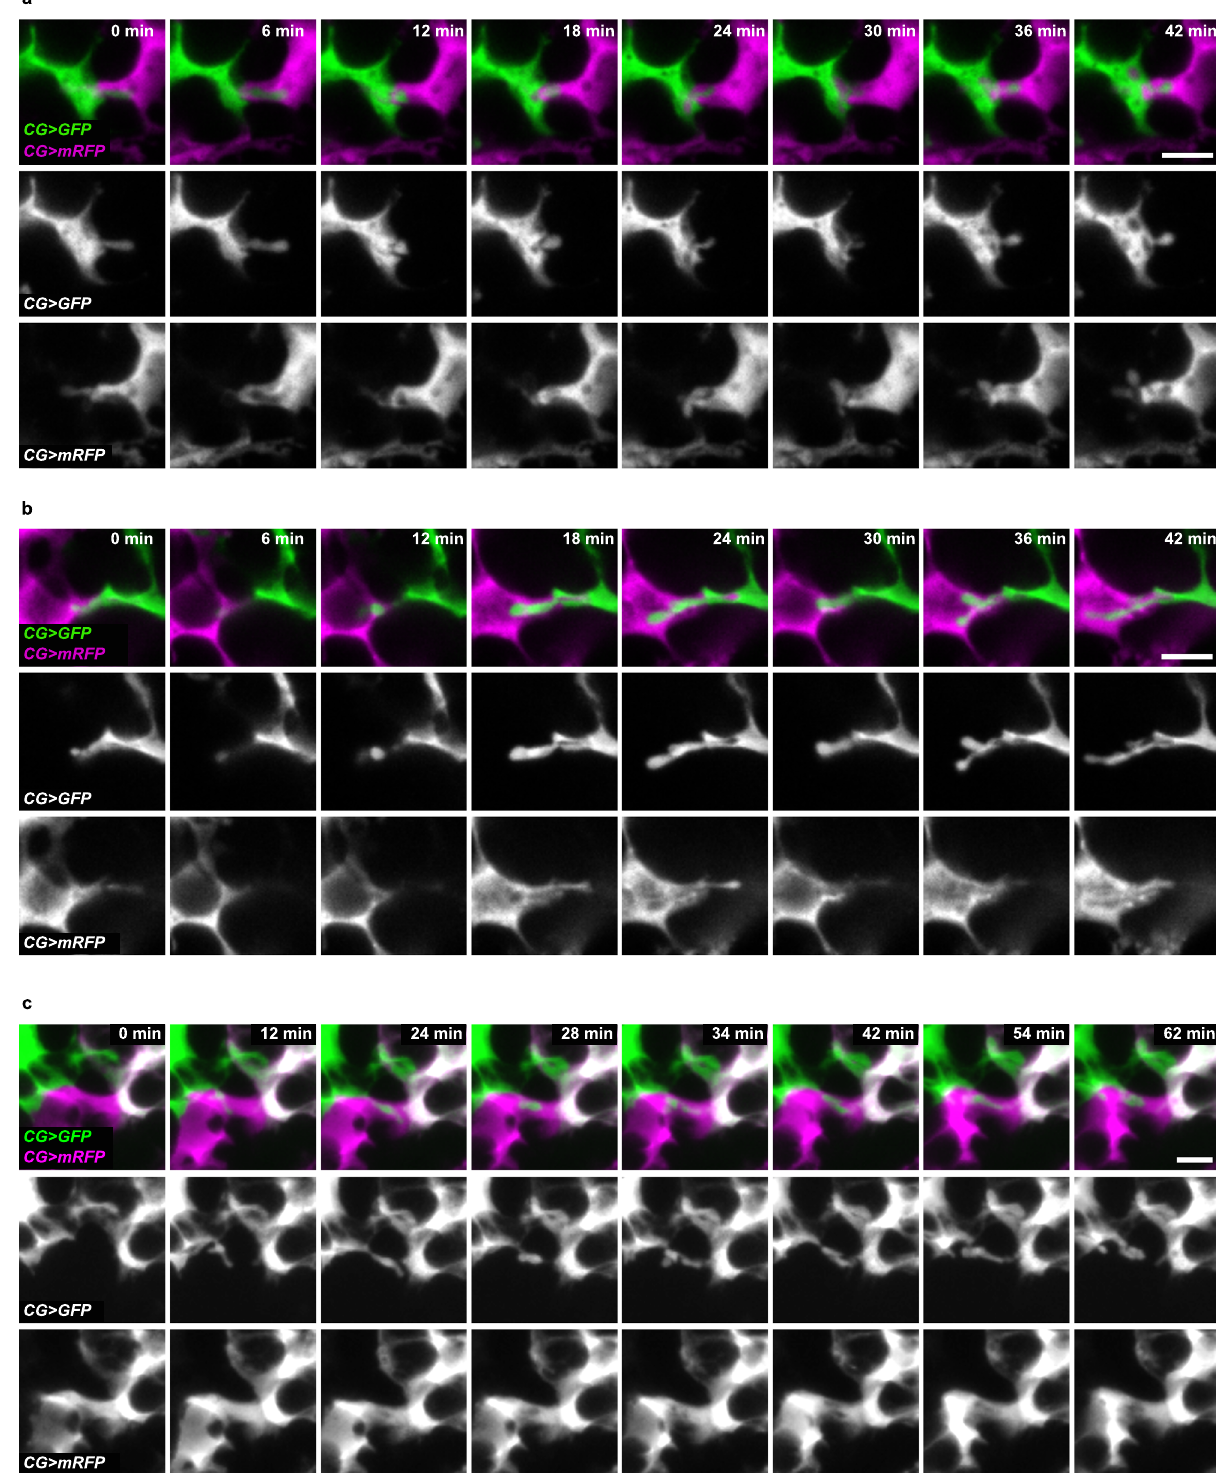
Fig. 7 | CG units exhibit a range of cytoplasmic interaction at their borders. a Still images of a time-lapse movie (Supplementary Movie 12) of the region of interaction between two neighbouring CG clones generated with CoinFLP and expressing either cytosolic GFP or RFP, at ALH34. Scale bar: 5 μ m. Restricted interactions are detected. b Still images of a time-lapse movie (Supplementary Movie 13) of the region of interaction between two neighbouring CG clones